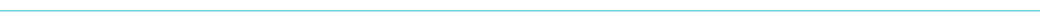
Figure 5: Management algorithm for CSF shunt-associated infections.CSF = cerebrospinal fluid; EVD/ELD = external ventricular/lumbar drainage; IV = intravenousBlue frame = intradural treatment 1 CSF leucocyte count > 5x10 6 cells/µl, with predominance of granulocytes, CSF lactate > 1.9 mmol/l, CSF total protein > 0.45 g/l, glucose CSF/blood ratio < 0.5 2 For low-virulent microorganisms, including coagulase-nega- tive staphylococci and Cutibacterium spp., reimplantation after 5–7 days; for S. aureus, Streptococcus spp., Enterococcus spp. and